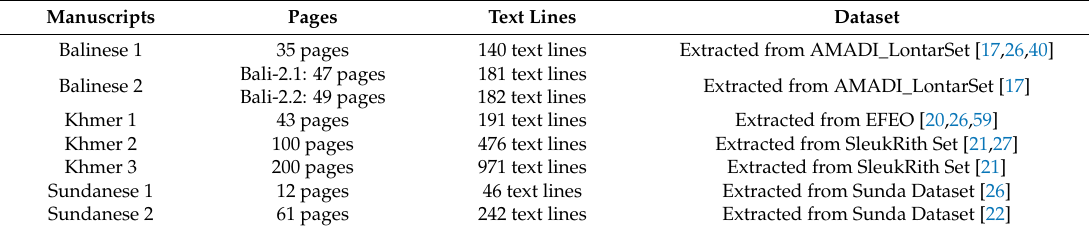
Table 2. Palm leaf manuscript datasets for text line segmentation